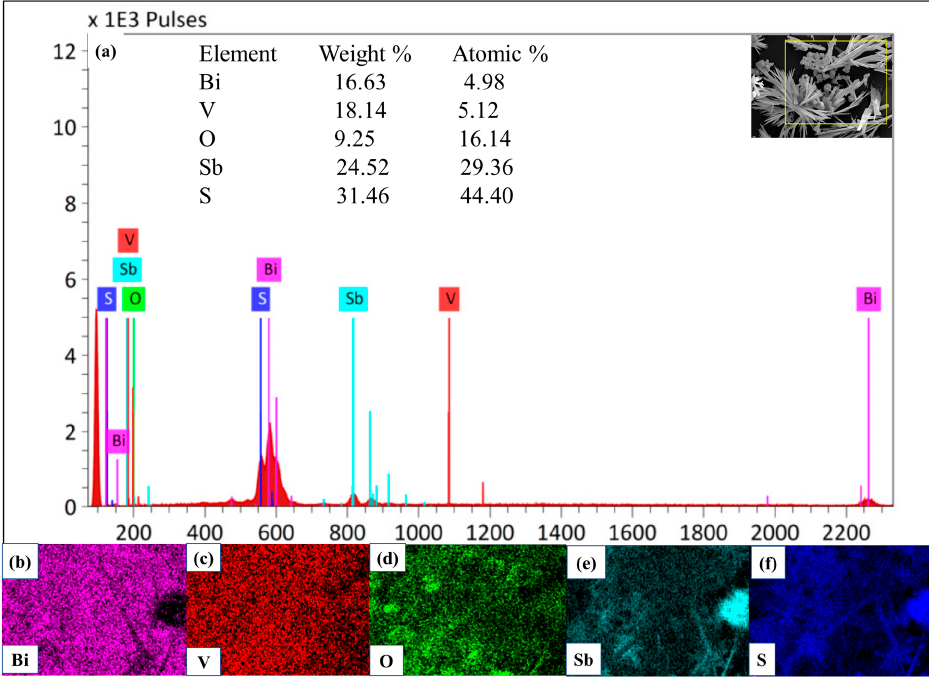
Figure 4. ( a ) EDS spectrum of the 13BVSBS photocatalyst with the corresponding SEM image and ( b – f ) elemental mapping of the 13BVSBS composite.